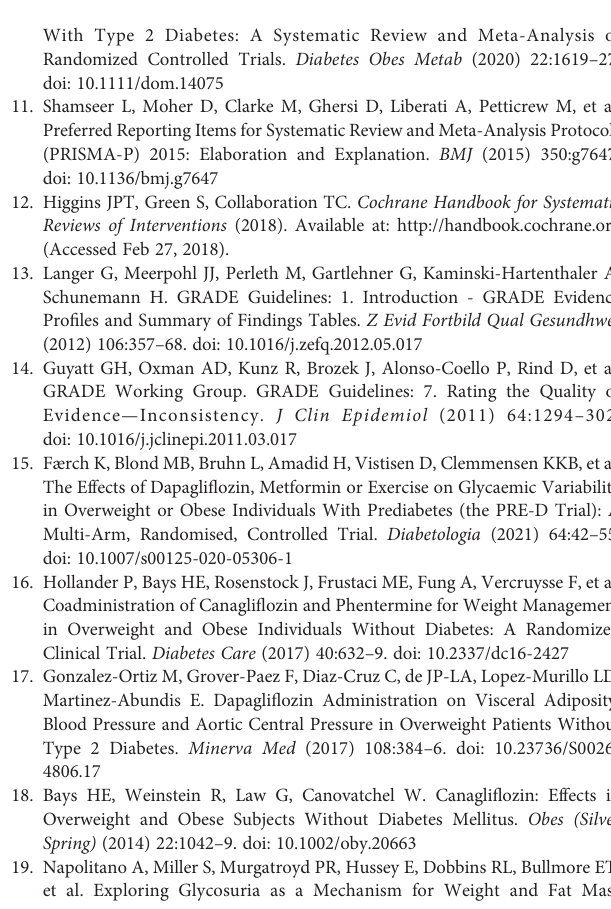
Supplementary Table 1 | PRISMA Checklist for the